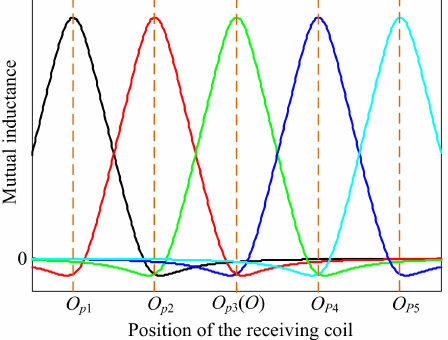
Figure 5. Characteristics of the mutual inductances varying with the position of the single receiving